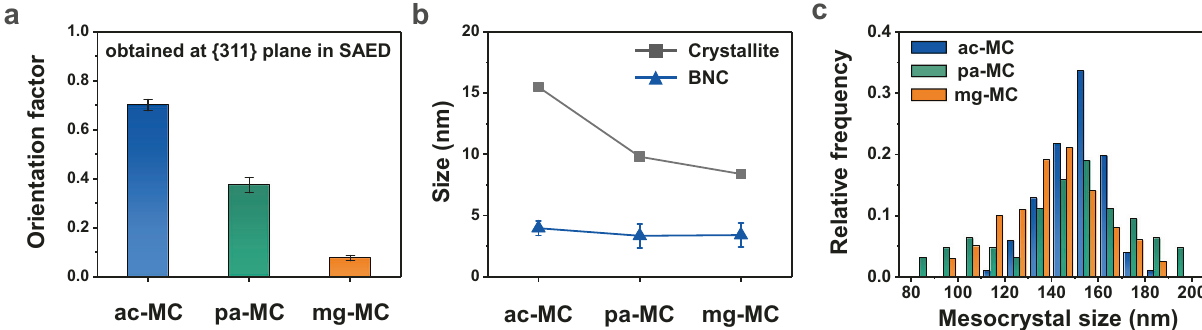
Fig. 4 Quantitative analyses of crystallographic alignment. a Orientation factor obtained from the azimuthal pro fi le of the SAED pattern of a single mesocrystal at a constant distance corresponding to the {311} plane. b Crystallite sizes calculated using the Debye – Scherrer equation and measured from the HR-TEM images. c Size distribution of each sample measured from 50 mesocrystals in the TEM images. Error bars in panels ( a ) and ( b ) indicate standard